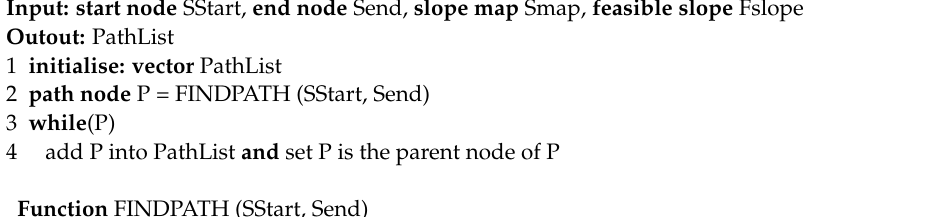
Algorithm 1: Improved A-Star